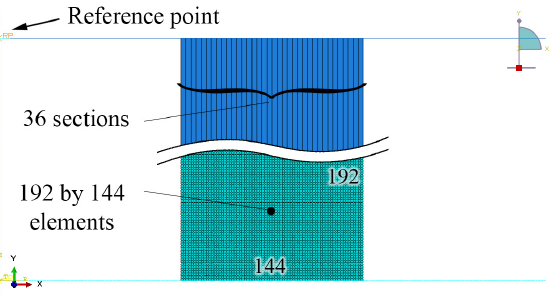
Figure 3. FE configuration of the ring model in ABAQUS, with the RP of the top platen where the initial velocity is applied.